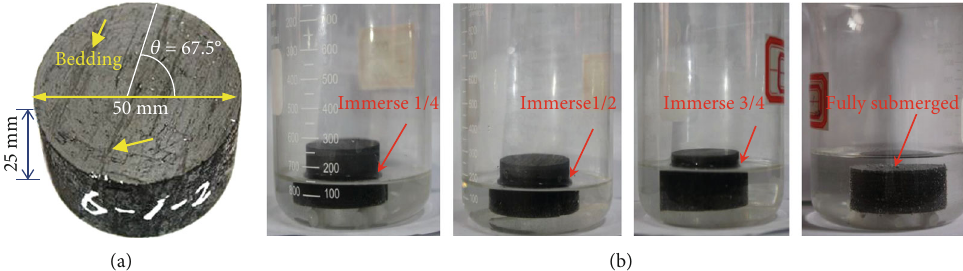
Figure 1: Schematic diagram of sample size and sample preparation. (a) The size and bedding angle of coal sample. (b) Water absorption process of saturated coal sample.